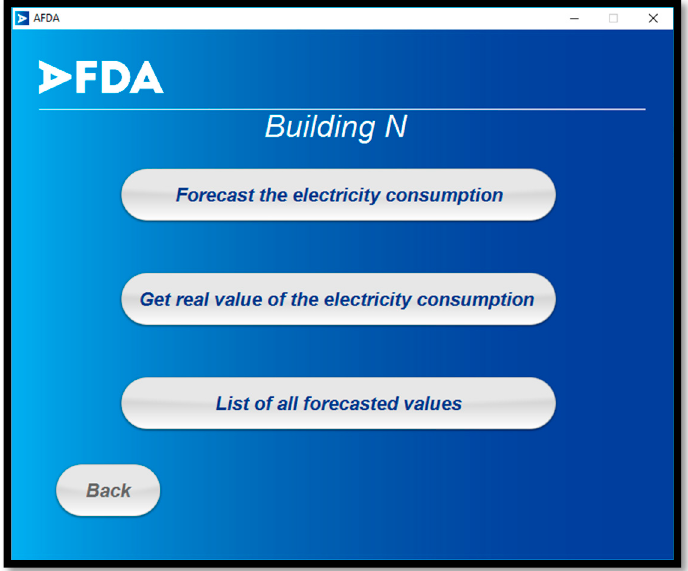
Appl. Sci. 2019 , 9 , x FOR PEER REVIEW